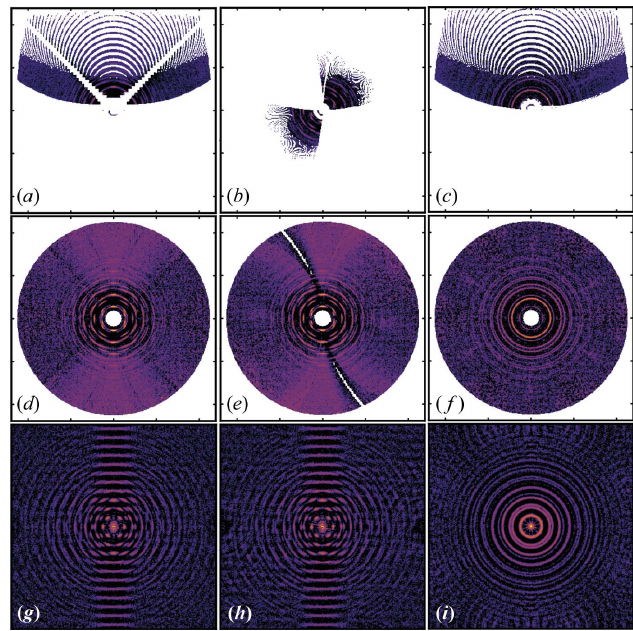
Figure 5 Slices through ( a )–( c ) the raw reconstructed scattering volume, ( d )–( f ) the processed total scattering structure function and ( g )–( i ) the txPDF, with arbitrary units on a logarithmic scale. The slices in the first column are perpendicular to x s , in the second column are perpendicular to y s and in the third column are perpendicular to z s , where x s , y s and z s are the sample coordinates, see the main text for details. All slices are through the origin of the diffraction space. The edge length is from (cid:4) 23.9 to 23.9 A˚ (cid:4) 1 in ( a )–( f ) and from (cid:4) 26.3 to 26.3 A˚ in ( g )–( i ), respectively. The void features in ( a )–( c ) result from the relatively high tilt step size of the measurement. The straight void lines in ( a ) result from masked high- absorption features from the substrate. The void lines in ( b ) and ( e ) are due to the masking of the